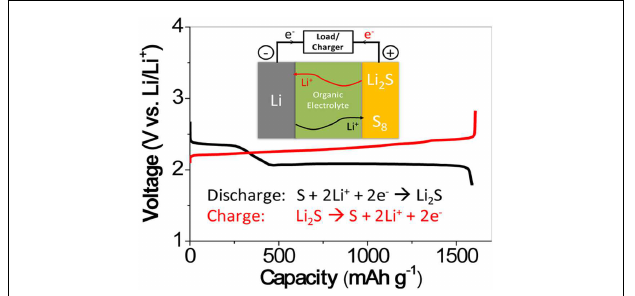
FIGURE 1 | Schematic diagram of a typical Li–S cell [adopted from Manthiram et al. (2013)] .